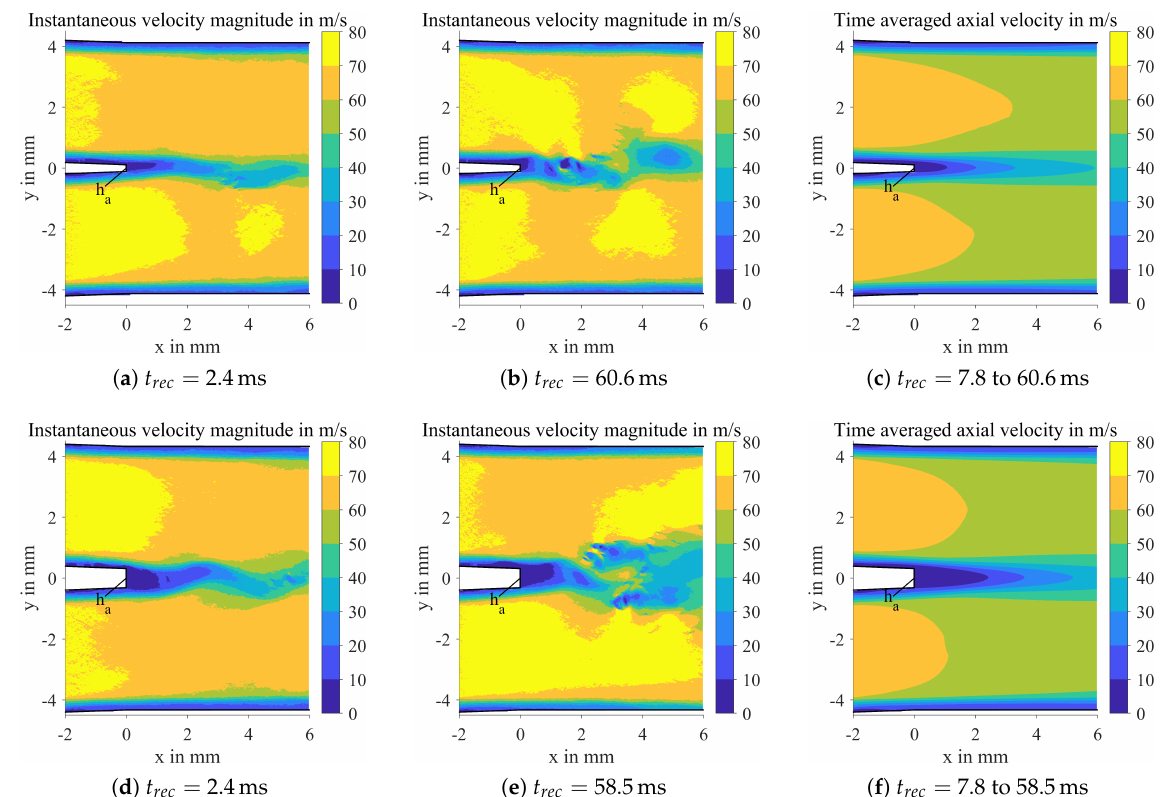
Figure 5. Instantaneous and time averaged airflow field for p g = 5bar, u g = 70m/s, h a = 230 and